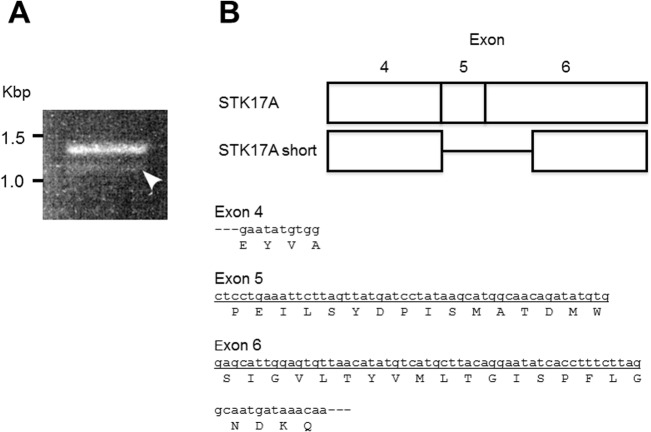
A short isoform of STK17A in HepG2 cells.(A) Polymerase chain reaction (PCR) of STK17A in HepG2 cells. The white arrowhead shows the band of the short isoform. (B) Schematic cDNA structure of a novel isoform of STK17A. The underlying cDNA sequence is lacking in the STK17A short isoform.